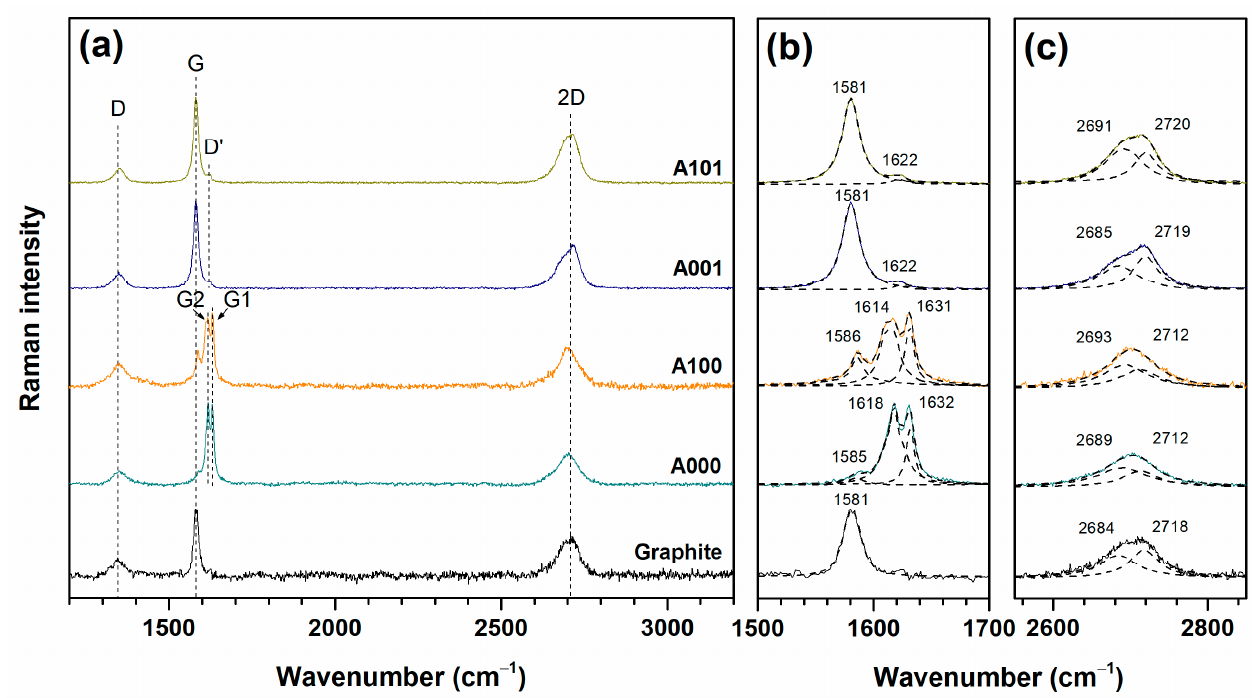
Figure 3. Raman spectra of GBS products obtained using (NH 4 ) 2 S 2 O 8 oxidizing agent ( a ), G band frequencies ( b ), and 2D band frequencies ( c ).